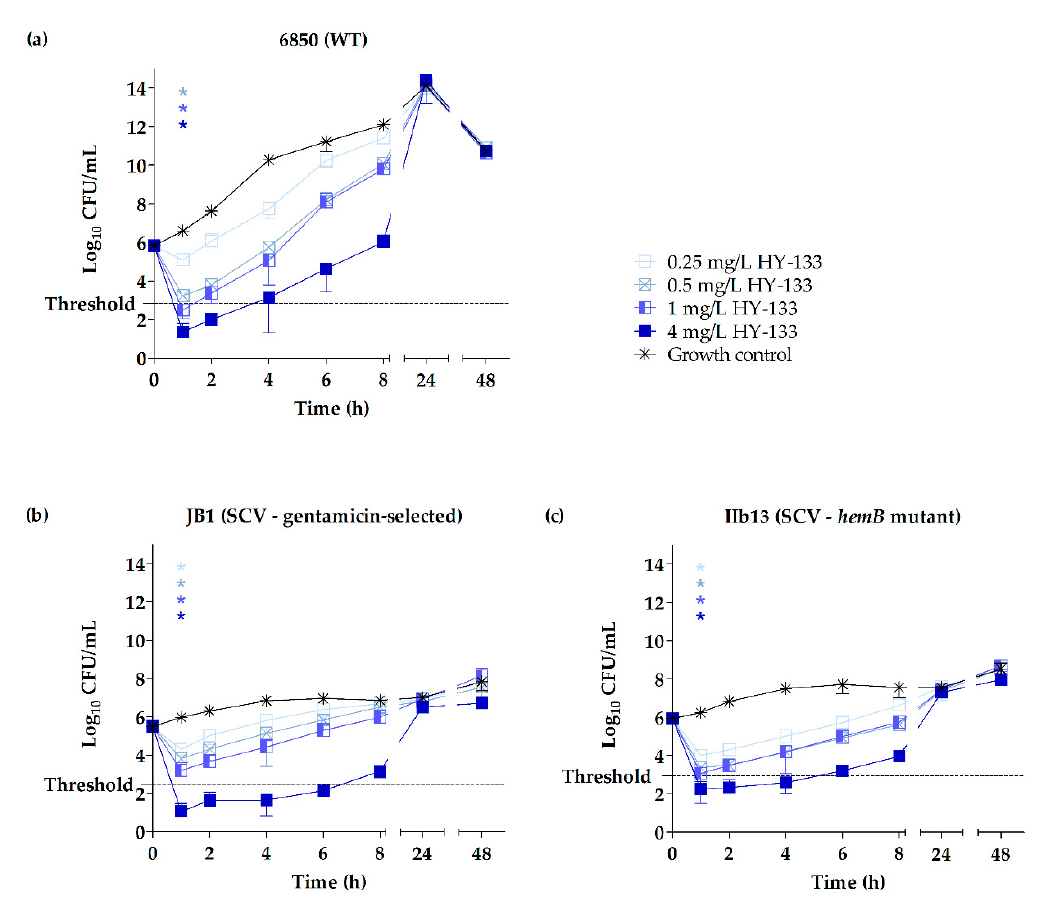
Figure 2. Time-kill curves of HY-133 shown by plots of mean values for the log 10 of the numbers of CFU/mL versus time for the highly cytotoxic and clinically virulent S. aureus WT strain 6850 ( a ) and corresponding SCVs JB1 ( b ) and IIb13 ( c ) tested against HY-133. The threshold implicates a ≥ 3 − log 10 decrease in CFU/mL. Time-kill curves for each strain were performed in triplicate (mean ± standard deviation). Asterisks denote statistical difference of the respective concentration of HY-133 used (defined by matching colors) with respect to the untreated growth control at 1 h; p ≤ 0.001 by one-way ANOVA.